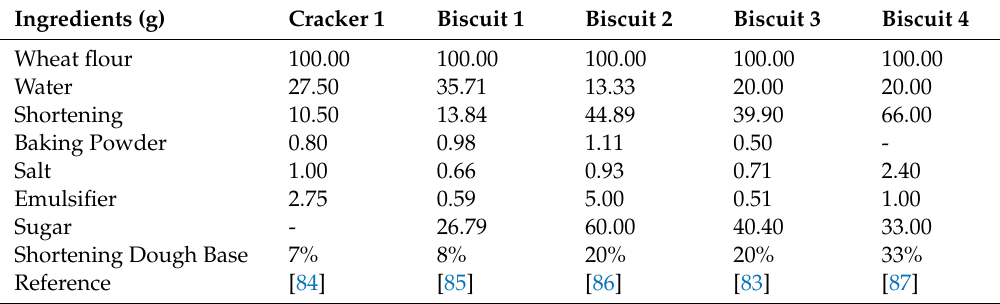
Table 3. Biscuit recipes based on 100